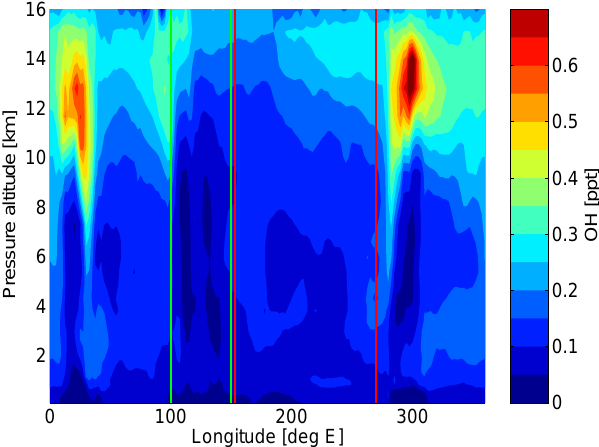
Fig. 6. Cross section of equatorial OH mixing ratio profiles (24h means) modeled with GEOS-Chem, averaged over the first half of October 2009. The area between the green lines denotes the re- gion of the OH minimum in Fig. 4c. The area between the red lines shows the longitudinal extent of the NASA DC-8 flights of the PEM-Tropics B campaign (which were not always directly at the